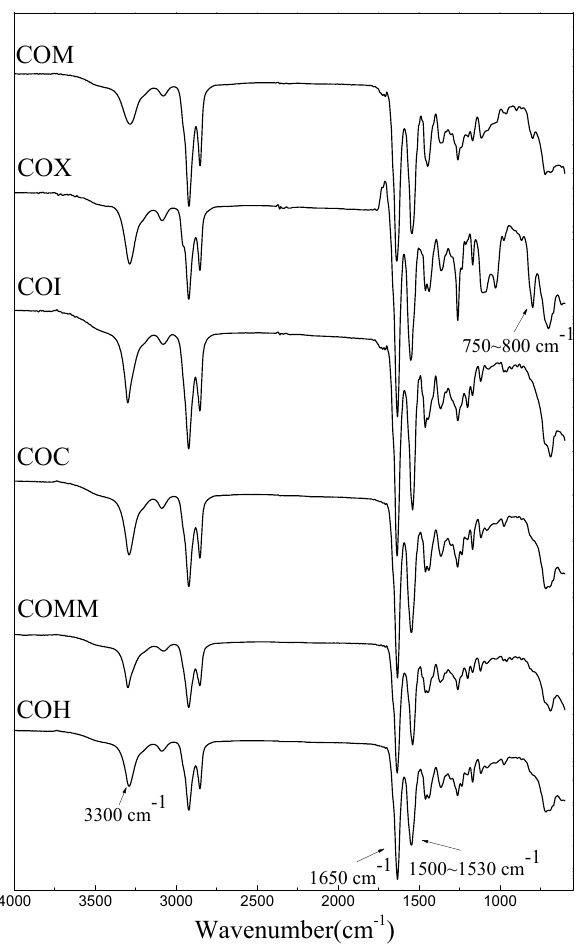
Figure 2. FTIR spectrum of PA6 containing cyclic compounds.